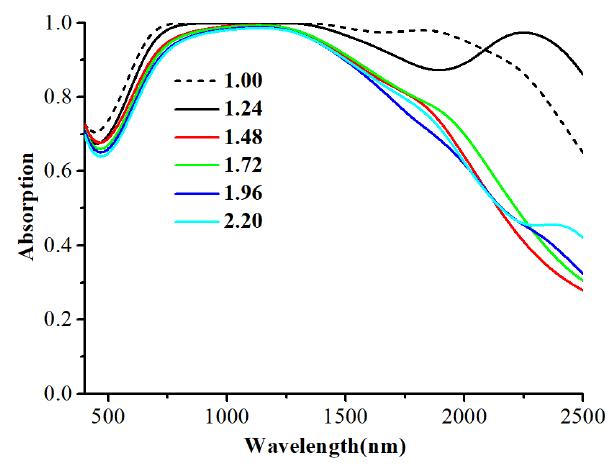
Figure 4. The absorption curve of the tungsten nanorods absorber with different RLS.